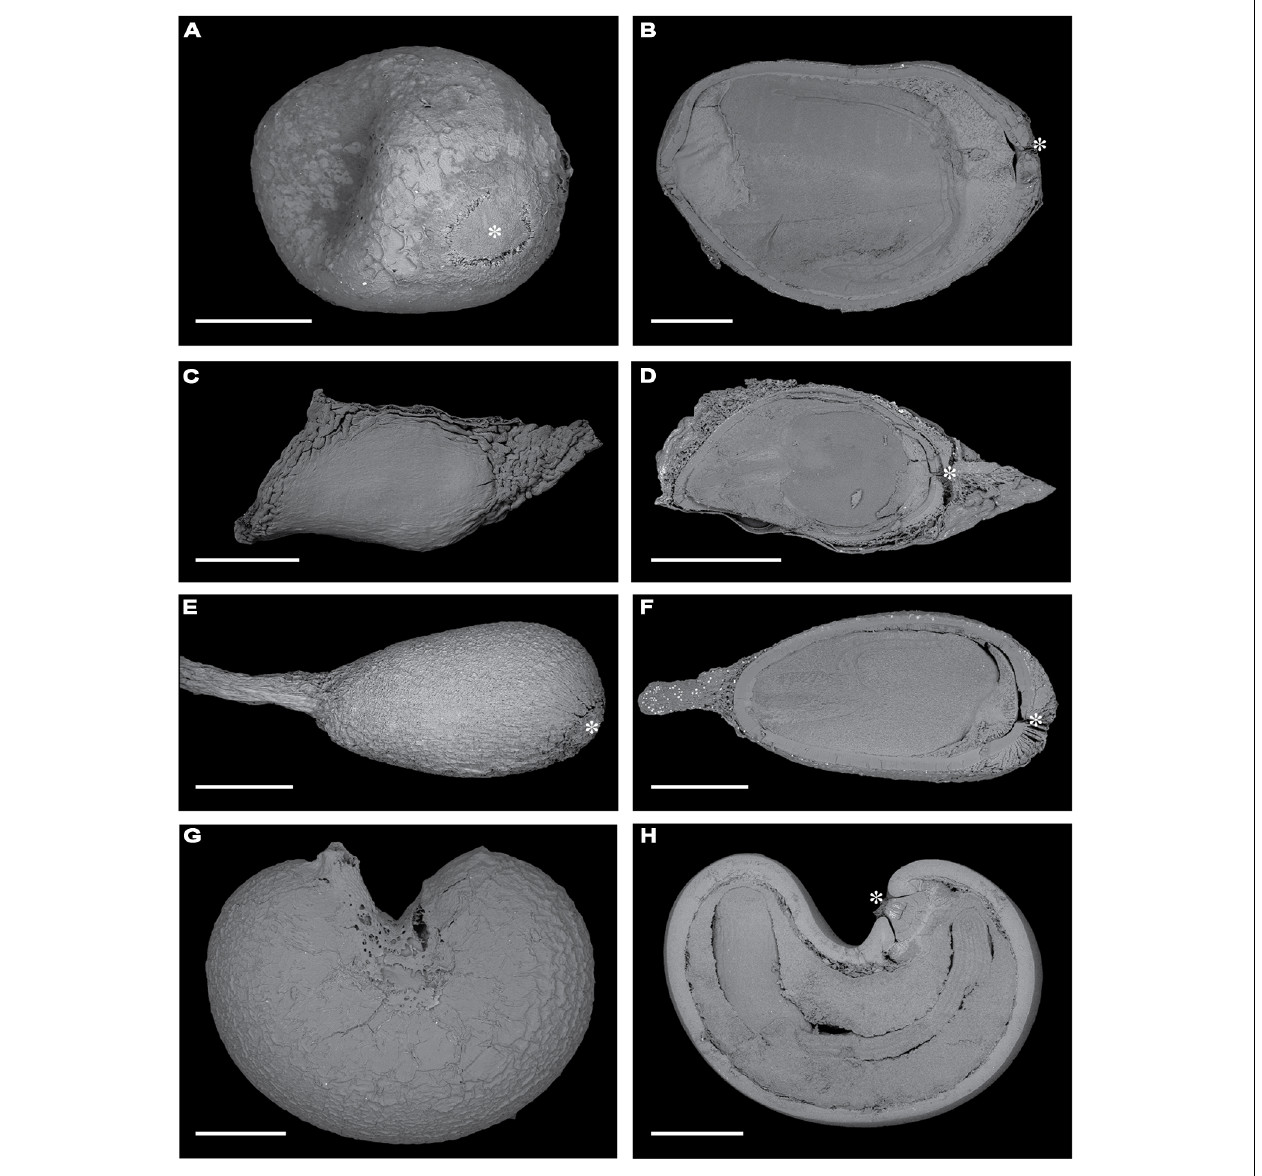
FIGURE 1 | Scanning electron microscopy images of the surfaces of fresh seeds (A, Apeiba ; C, Luehea ; E, Ochroma ; G, Cochlospermum ) and longitudinal sections of seeds (B, Apeiba ; D, Luehea ; F, Ochroma ; H, Cochlospermum ). Scale bar = 1 mm. An asterisk highlights the chalazal area when